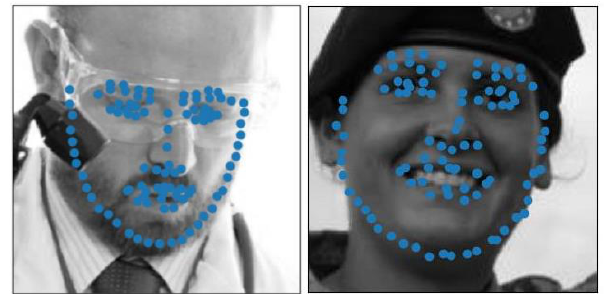
Fig. 3: Example of face images with detected key points.